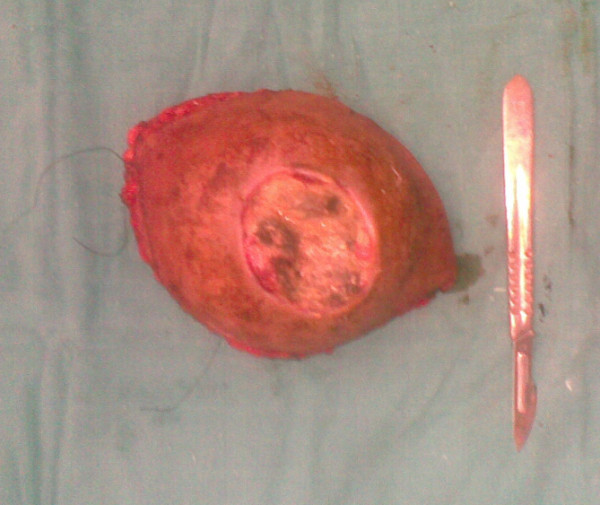
Macroscopic aspect.